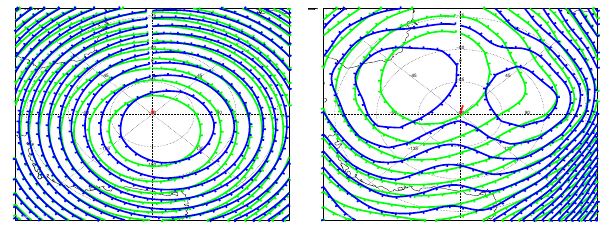
Figure 4. (Left) Results of the GROGRAT “climatological” run for the wave observed on 18 August 2004 using background pressures, temperatures, and horizontal winds reconstructed from NRLMSISE-00 and HWM-93. (Right) Results of the GROGRAT run for the same wave using an atmosphere constructed from ECMWF Reanalysis below 50km altitude and NRLMSISE-00 and HWM-93 between 50 and 100km altitude. The two contours in each panel represent geopotential heights at 3mbar (blue) and 10mbar (green), and the red line in each panel represents the wave ray path.